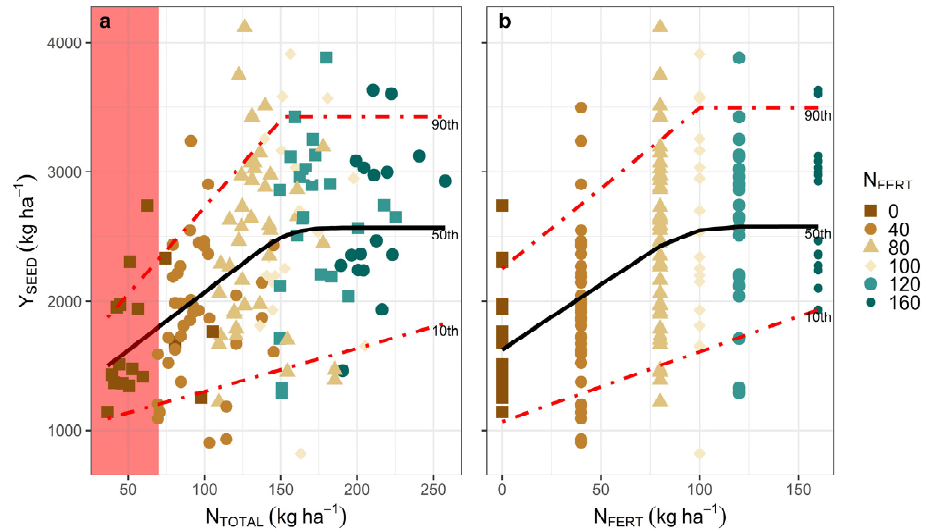
Figure 2. Quantile regression models fitted to different percentiles relating Y SEED in response to N TOTAL ( a ) and N FERT rate ( b ). Each data point is a plot on a farm with fertilization treatment. Red zones represent the N SOIL supply in unfertilized plots (control).